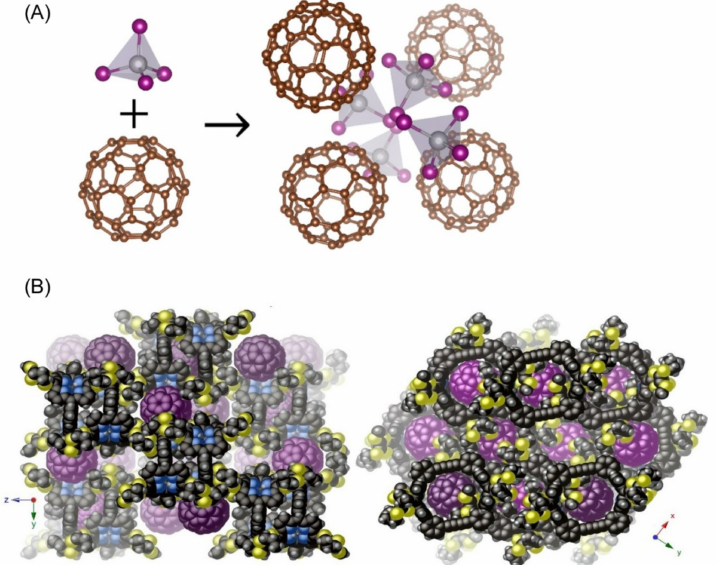
Figure 10. Fullerene-based molecular complex: ( A ) crystals from an icosahedral fullerene (C 60 ) and tetrahedral SnI 4 molecules; and ( B ) ball-and-socket type complex with C 60 and extended tetrathiafulvalene-porphyrin scaffold. Reprinted with permission from [158]. Copyright 2020, American Chemical Society. Reprinted with permission from [159]. Copyright 2020, American Chemical